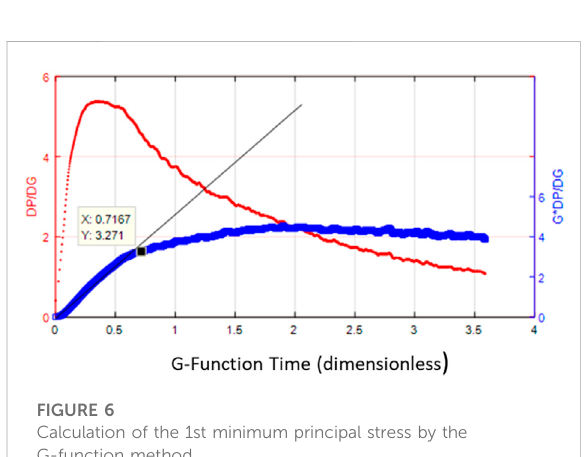
FIGURE 6 Calculation of the 1st minimum principal stress by the G-function